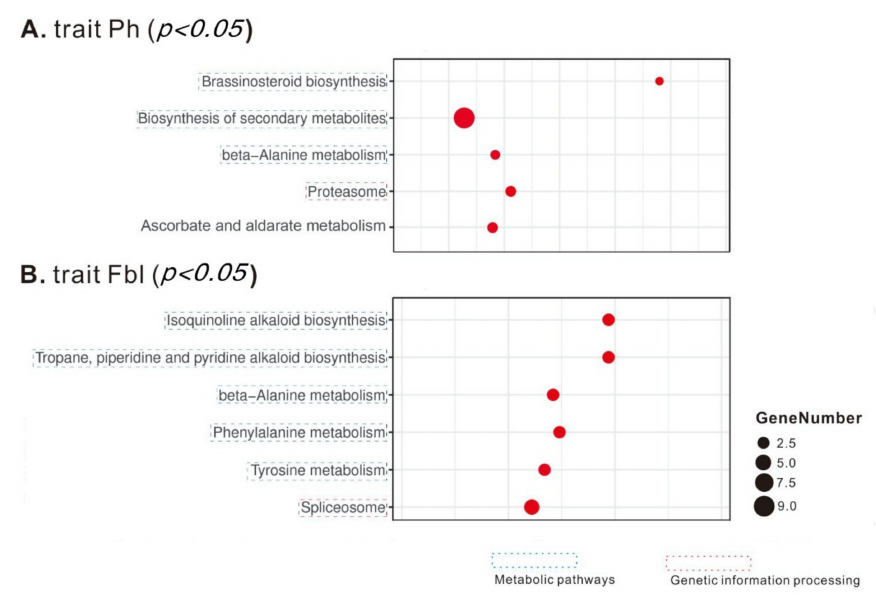
Figure 3. The KEGG pathway enrichment scatter plots of the candidate genes for Ph ( A ) and Fbl ( B ). Only significant pathways are shown here. The number of candidate genes is indicated by the size of a circle.